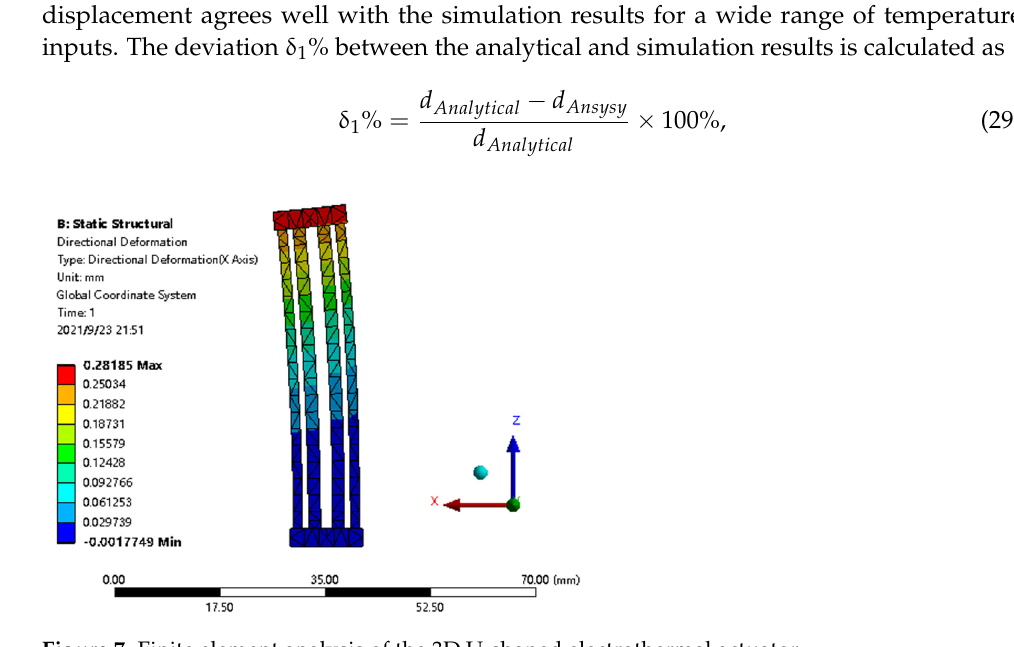
Figure 7. Finite element analysis of the 3D U-shaped electrothermal actuator. Table 3. Comparison between analytical and simulation results.